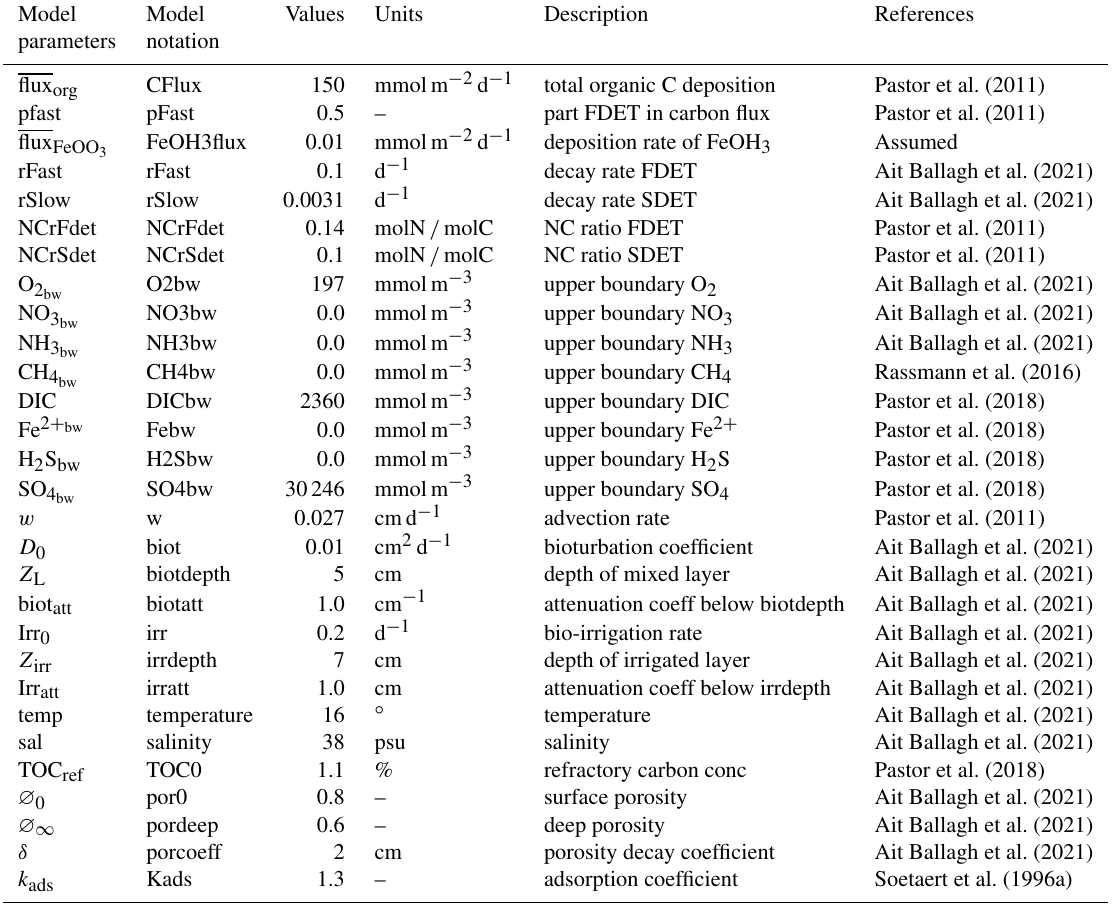
Table 3. Core parameters used in the